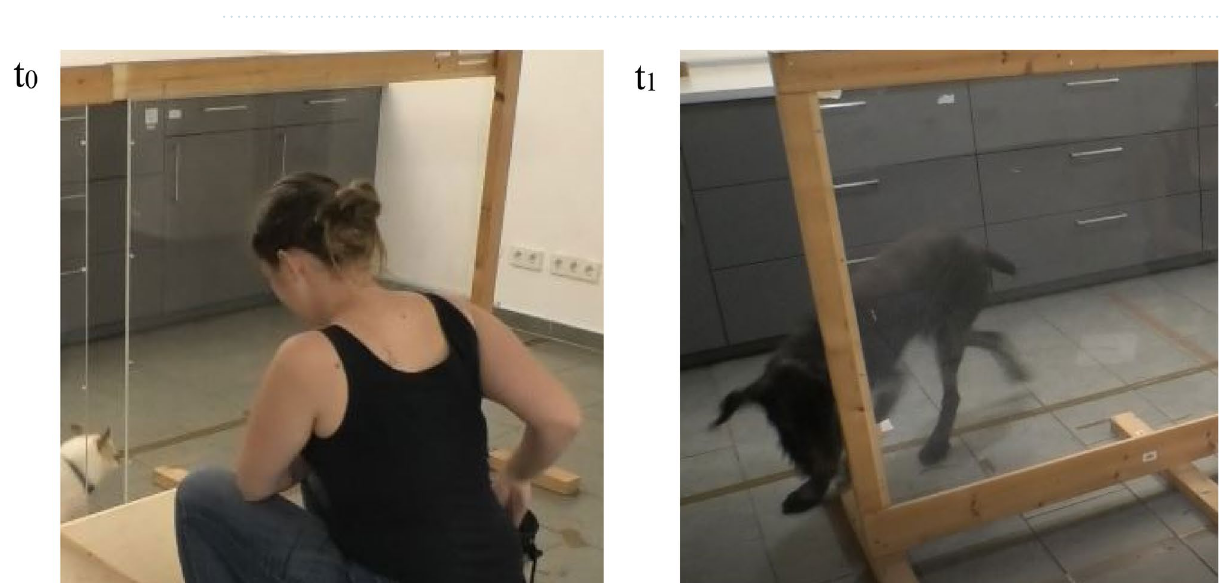
Figure 5. (t 0 ) shows an example of a starting point of a time interval: E1 retrieves the reward. (t 1 ) shows an example of an end point of a time interval: dog’s head aligns with